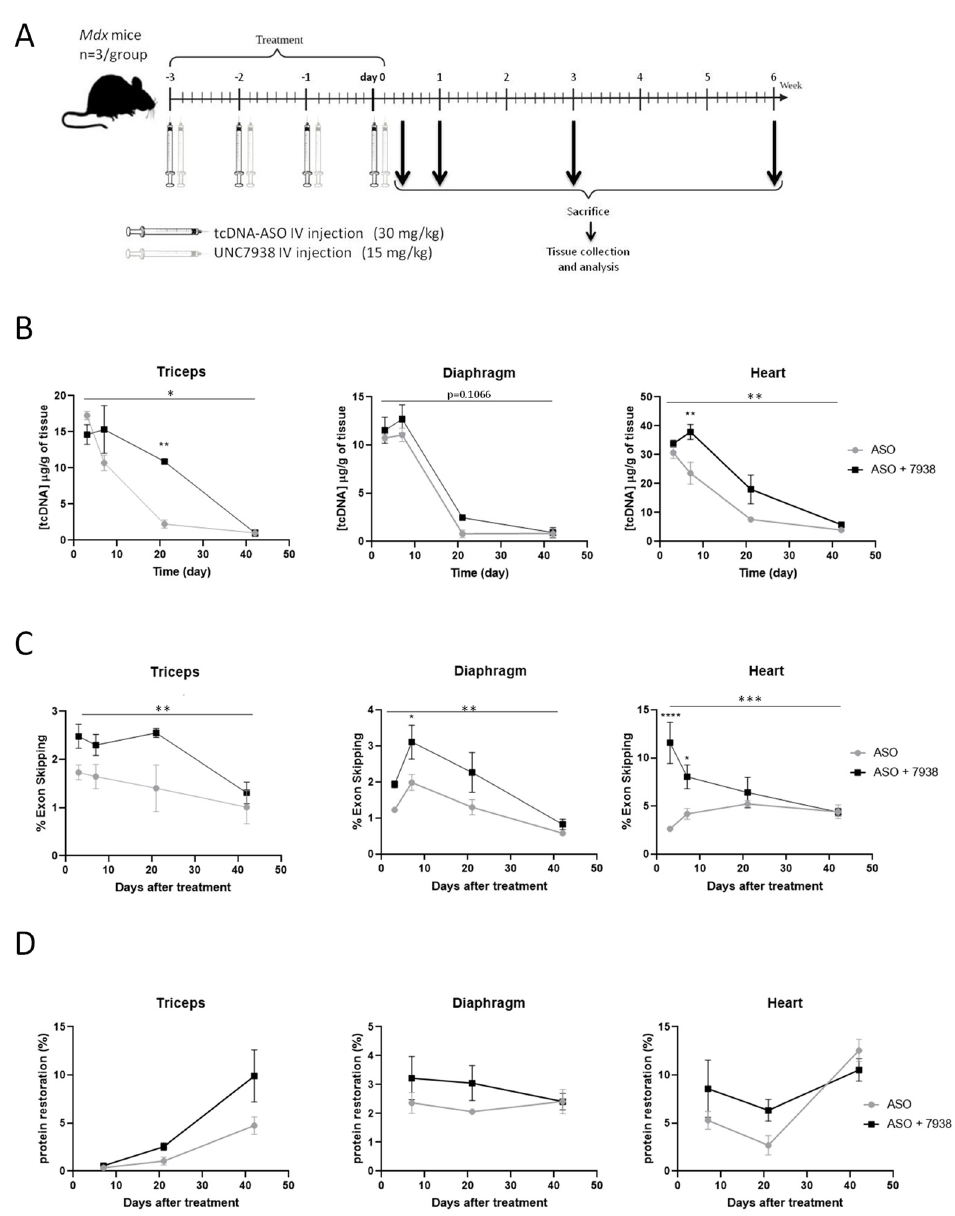
Figure 2. Kinetics of UNC7938 effect on exon skipping therapy in mdx mice. ( A ) Schematic representation of the injection protocol with tcDNA-ASO and the OEC UNC7938 in mdx mice with the different time points of analysis. ( B ) Quantification of ASO in triceps, diaphragm, and heart at different time points (72 h, one wk, three wks, and six wks) after the last ASO injection. N = 3 mice per group and per time point. * p < 0.05, ** p < 0.01 compared to ASO analyzed by two-way ANOVA. ( C ) Effect of UNC7938 on exon skipping level. qPCR quantification of exon 23 using taqman qPCR in the triceps, diaphragm, and heart at different time points (72 h, one wk, three wks and six wks) after last ASO injection. N = 3 mice per group and per time point. * p < 0.05, *** p < 0.001, **** p < 0.0001 compared to ASO analyzed by two-way ANOVA. ( D ) Quantification of dystrophin restoration levels by western blot in treated mdx mice at different time points (one wk, three wks, and six wks). Results are expressed as mean ± SEM; N = 3 mice per group and per time point.